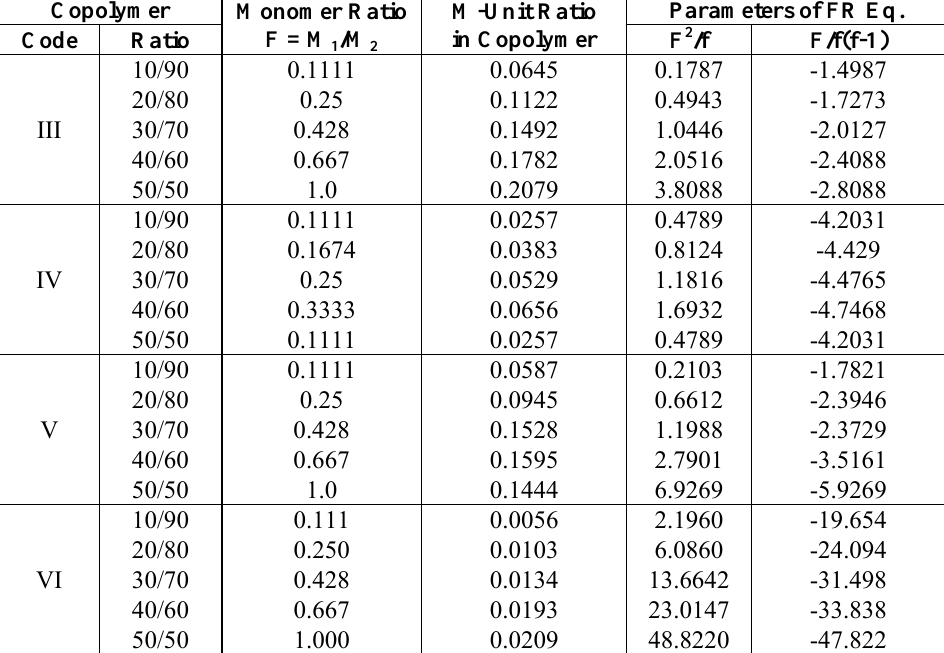
Table 4. Monomer reactivity ratios and the FR parameters of copolymers III–VI